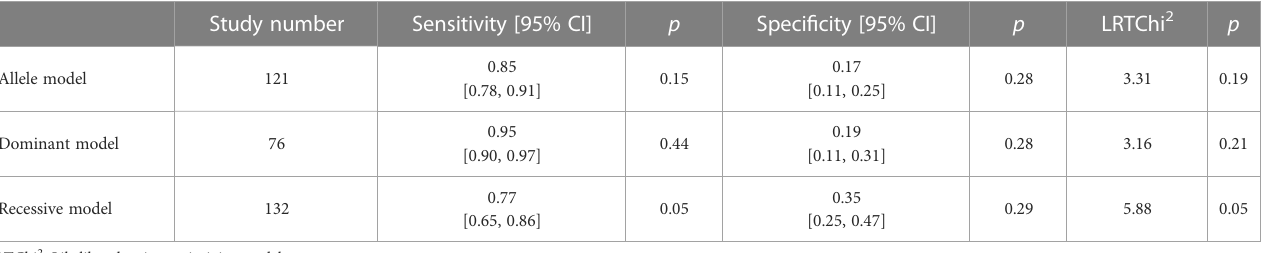
TABLE 3 Subgroup analyses according to the cancer type.